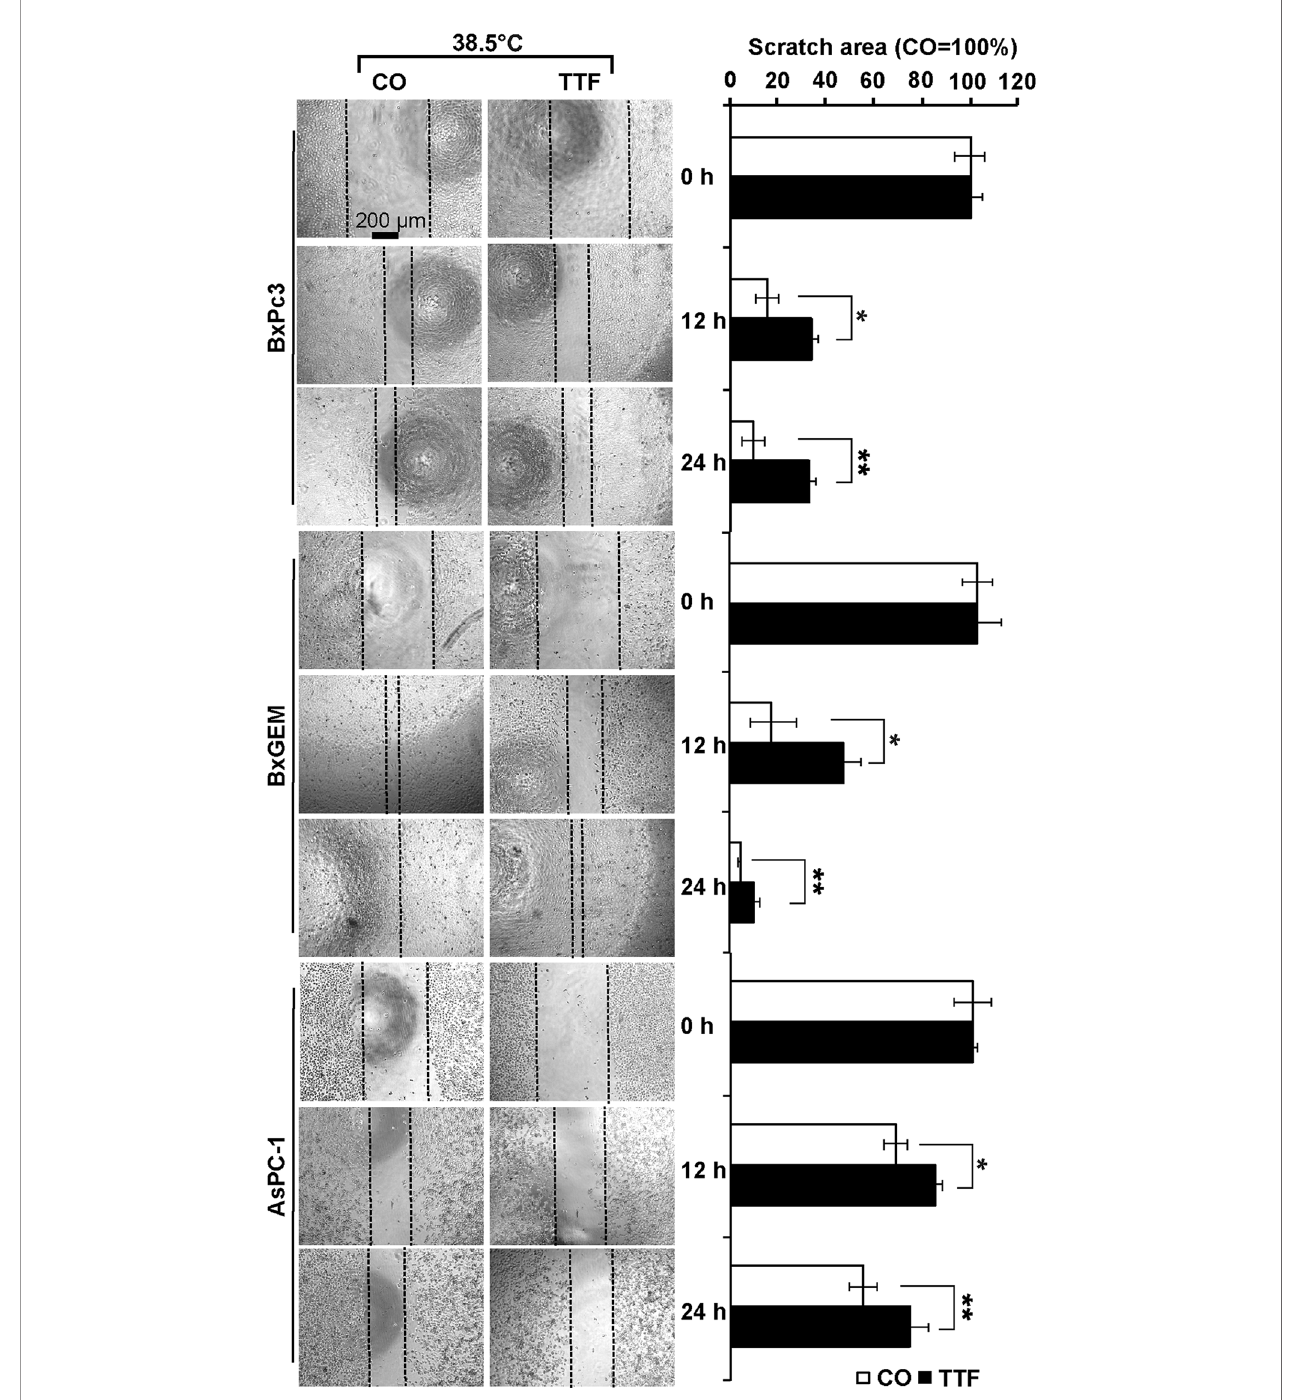
FIGURE 3 | TTField-mediated inhibition of migration is stronger upon combination with hyperthermia. AsPC-1, BxPC-3 and Bx-GEM cells were seeded at a density of 4,000 cells/well in 96-well plates and grown to 90% con fl uency overnight. The cell layer was scratched with the tip of a 100-µL pipet, followed by treatment of the cells with TTFields at 38.5°C for 24 h. The controls (CO) were incubated at 38.5°C without exposure to TTFields. The closure of the wounded region was evaluated by microscopy at 0, 12 and 24 h after scratching. The gap width was measured using ImageJ. Representative images are shown on the left, and the means are shown in bar graphs on the right. The data are presented as the means ± SD. *P < 0.05, **P <